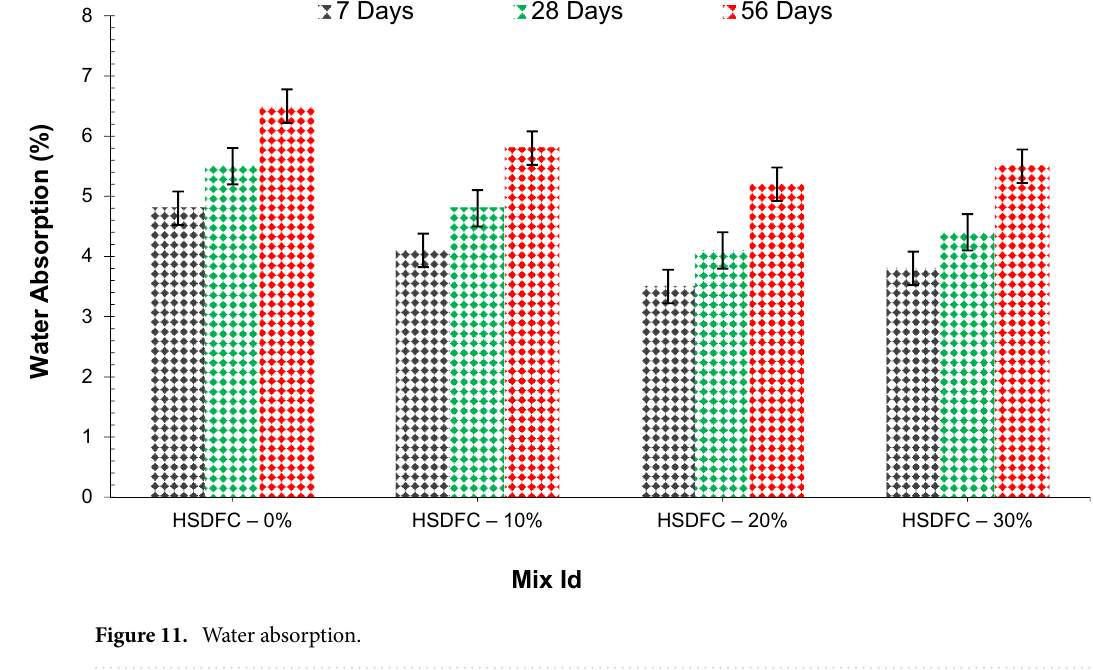
Figure 11. Water absorption.